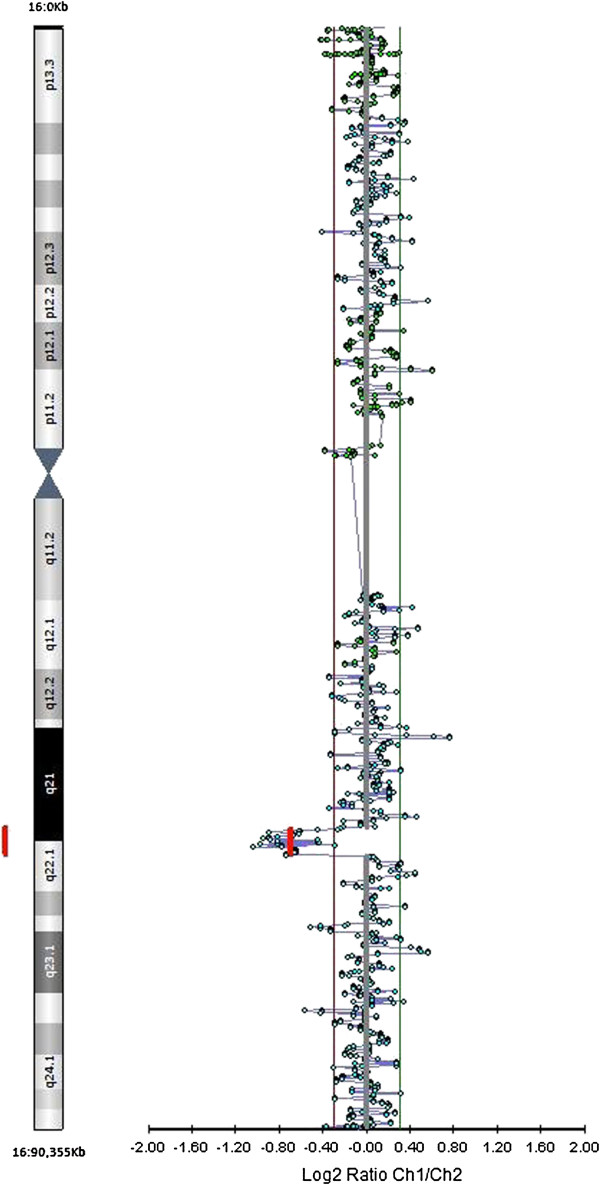
Array-CGH analysis. The analysis shows a partial deletion of the 16q21q22.1 tract, spanning approximately 2.1 Mb (chr16:65713516–67842736 [Hg19]), involving the region in which the 12q14q21.1 tract was inserted.